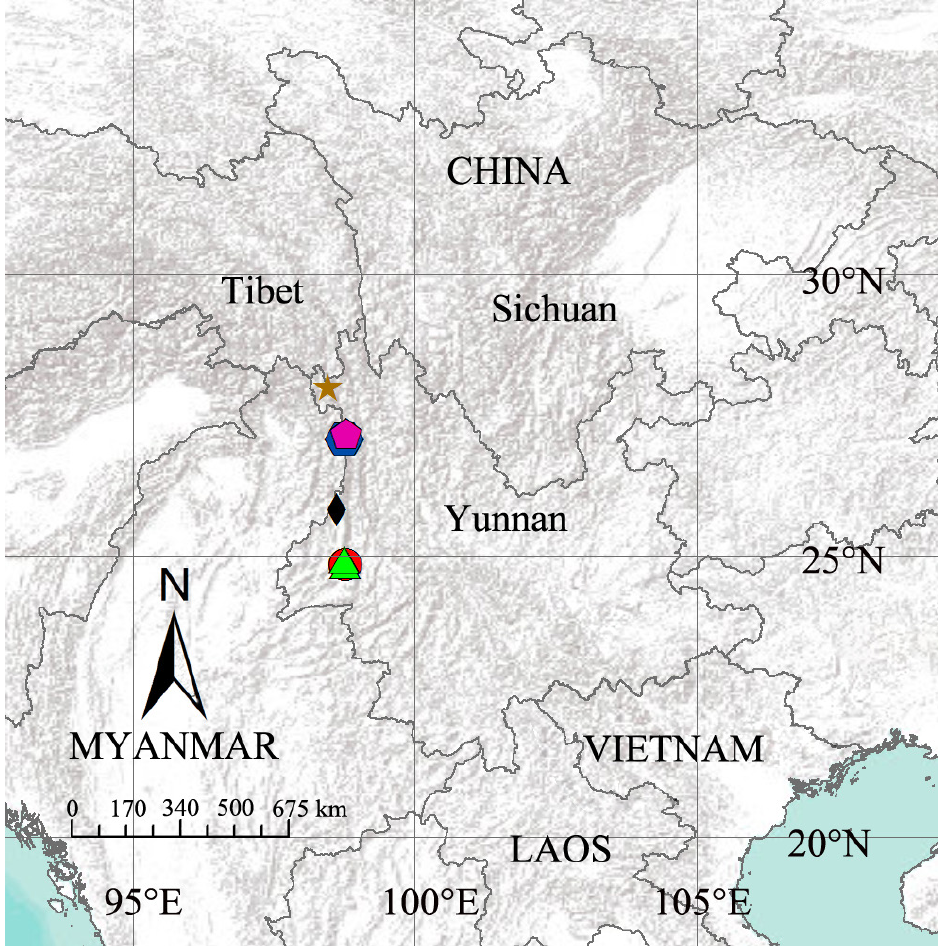
Fig. 39. Map indicating the type localities of Acroterius circinatus sp. nov. ( ), A. longidentatus sp. nov. ( ), A. longimultus sp. nov. ( ), A. longiprojectus sp. nov. ( ), A. ovatus sp. nov. ( ) and A. parvus sp. nov. (